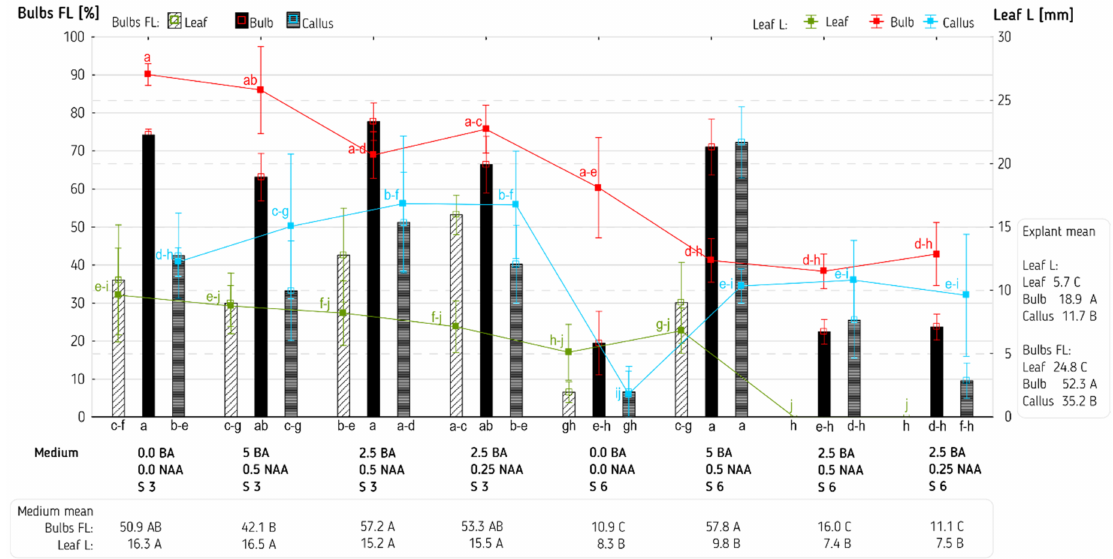
Figure 4. The effect of different explant and medium type on the percentage of adventitious bulbs forming leaves (Bulb FL) and on the leaves’ length (Leaf L). Mean values ± SE with different small letters as well as mean values with different large letters are significantly different according to Duncan’s multiple range test at p ≤